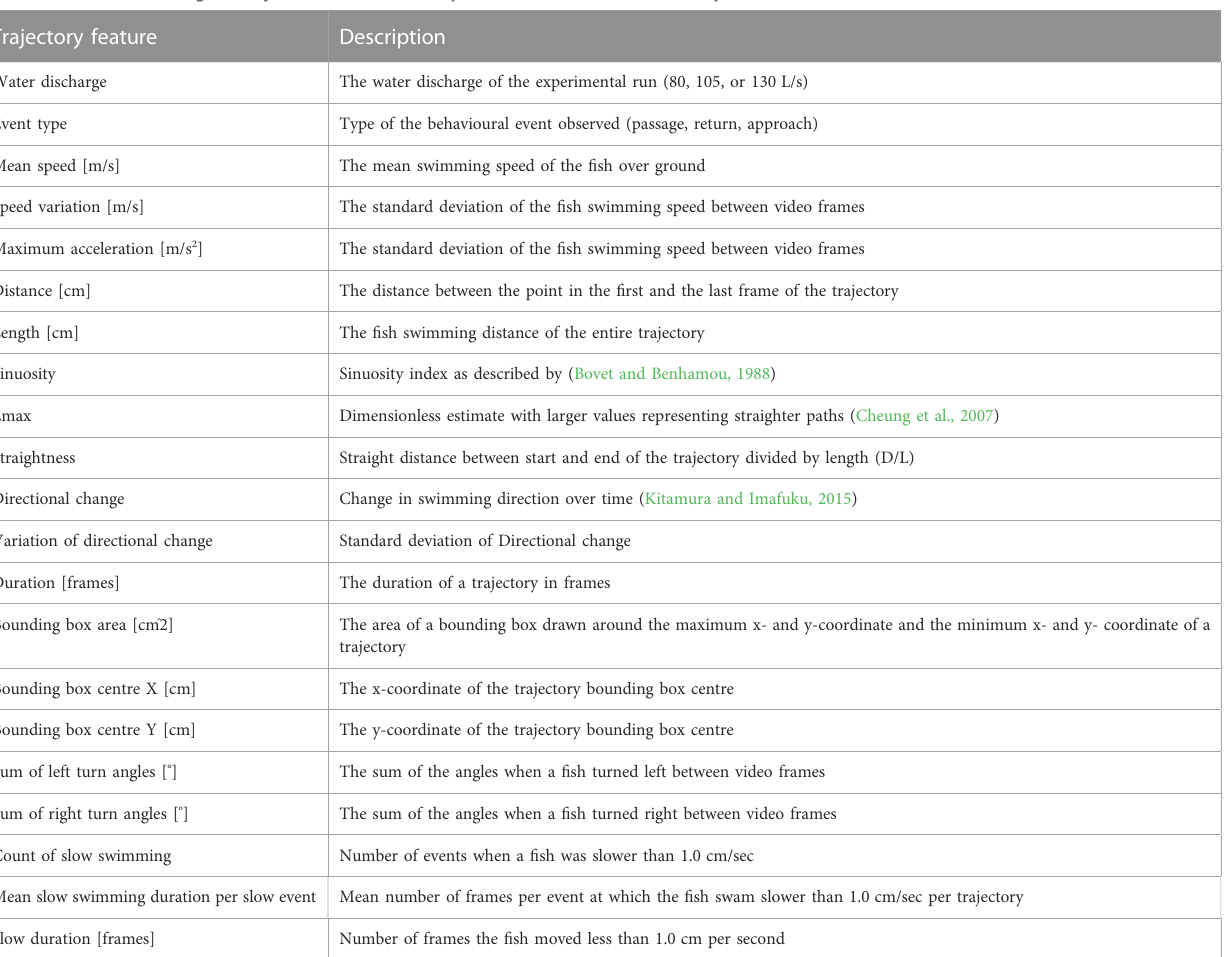
TABLE 1 Features describing the trajectories that were computed for the random forest